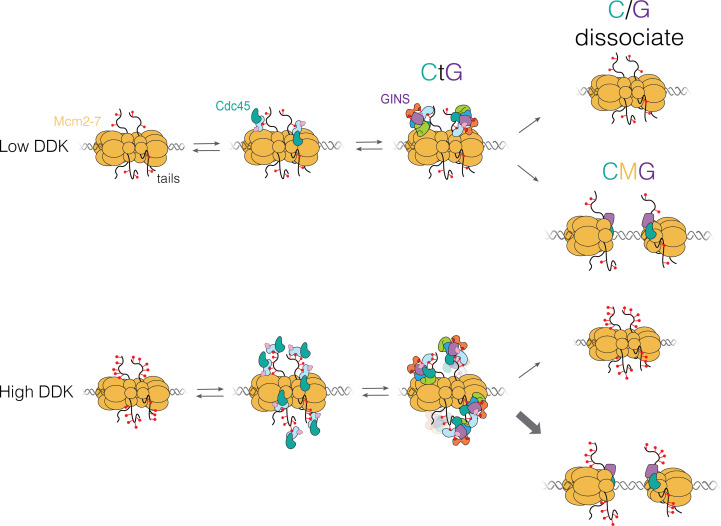
Proposed model for Cdc45-Mcm2-7-GINS (CMG) formation.Dbf4-dependent kinase (DDK) levels control the amount of Mcm4 and Mcm6 N-terminal tail phosphorylation. These modifications indirectly (via Sld3/7) recruit Cdc45 and GINS, forming the Cdc45-tail-GINS (CtG) intermediate. The CtG intermediate can then follow one of two paths: (i) dissociation or (ii) deposition onto the structured core of the Mcm2-7 helicase to form the CMG. We hypothesize that the rate of this conversion is the same for any CtG, but it is infrequent. Thus, having more CtGs (e.g., at higher DDK levels) increases the probability of CMG formation, which we assume is irreversible. Relevant proteins are labeled in the illustration; red lollipops represent phosphorylations. C/G: Cdc45-GINS.